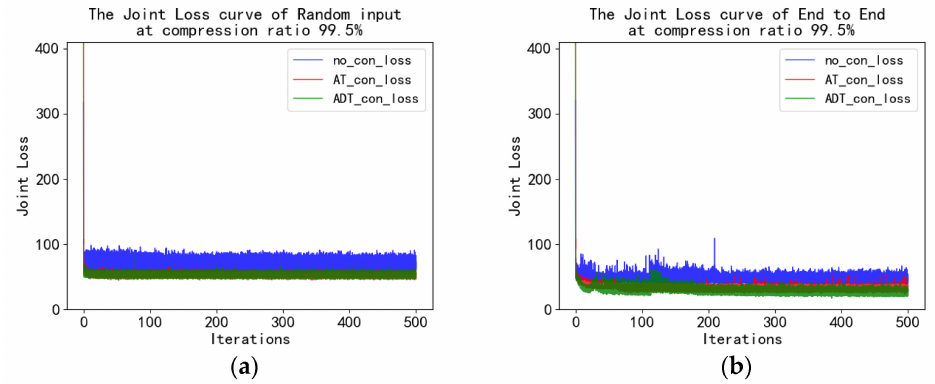
Figure 5. The joint loss curves for ( a ) random input and ( b )